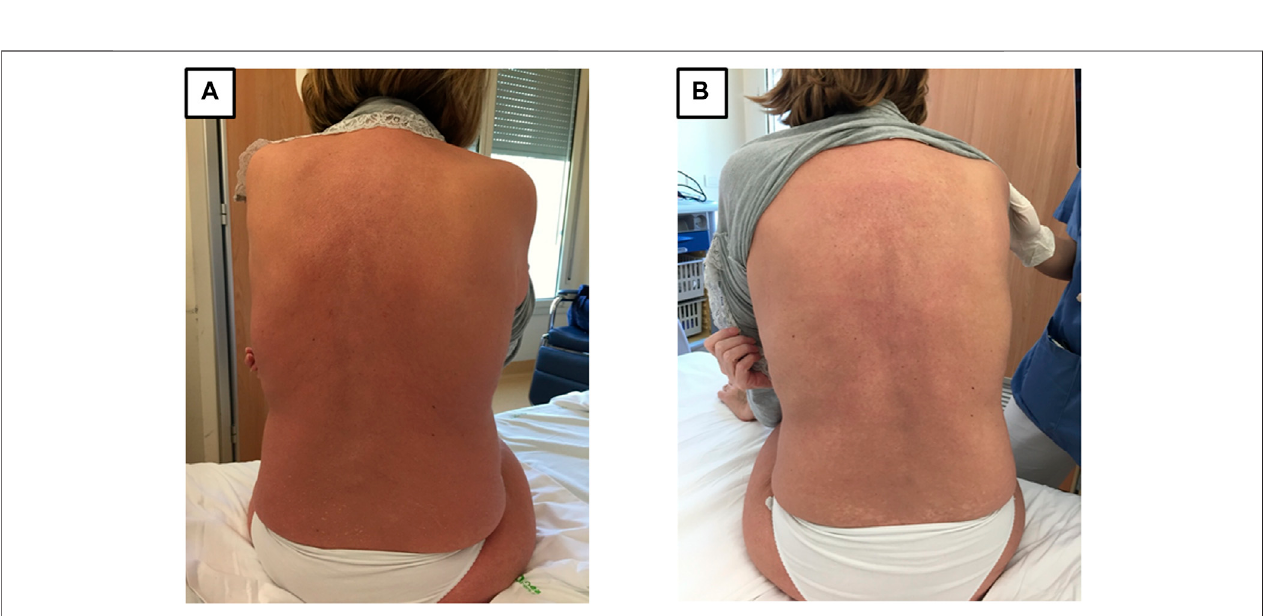
FIGURE2| Cutaneousand mucosal involvement in Stevens-Johnsonsyndrome (day45 ofosimertinib). (A) Diffusepainful G3erythemaover theentire bodyupon hospital admission. The patient also had mucositis ofthe oral cavity (with blisters), pharynx(causing dysphagia), eyes, vagina, and nose (with ulcers causing episodes of epistaxis). SCORTEN score 3 (Bastuji-Garin, et al., 2000). (B) Reduction in the diffuse erythema, with areas of fl aking and depigmentation (day 60).